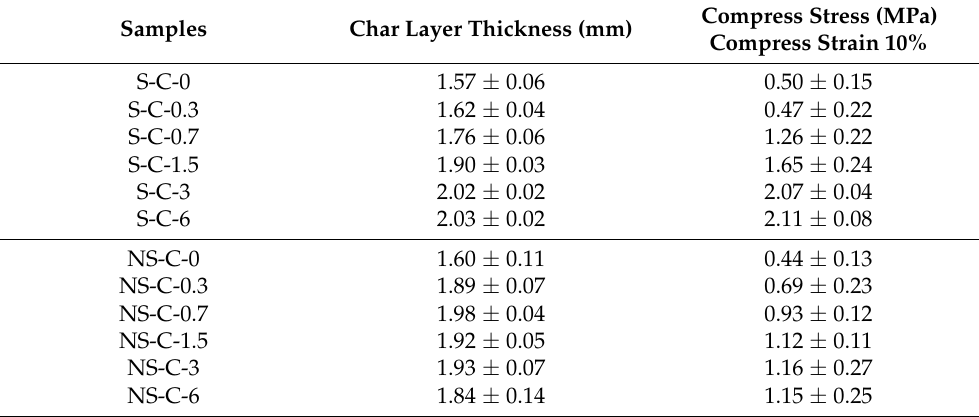
Table 1. Effects of MWCNTs content on thickness and compress properties of char